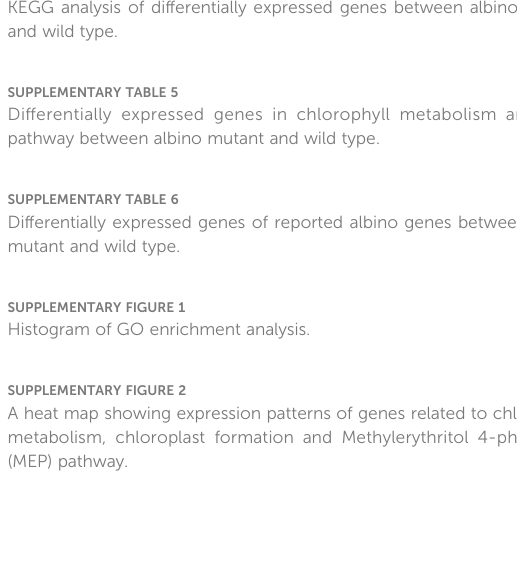
KEGG analysis of differentially expressed genes between albino mutant and wild type.